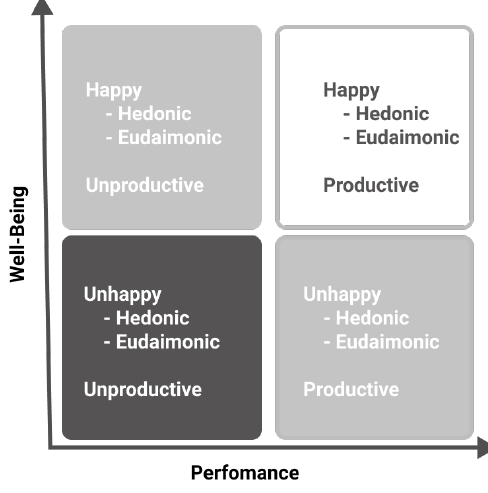
Figure 1. Sustainable well-being at work [16].